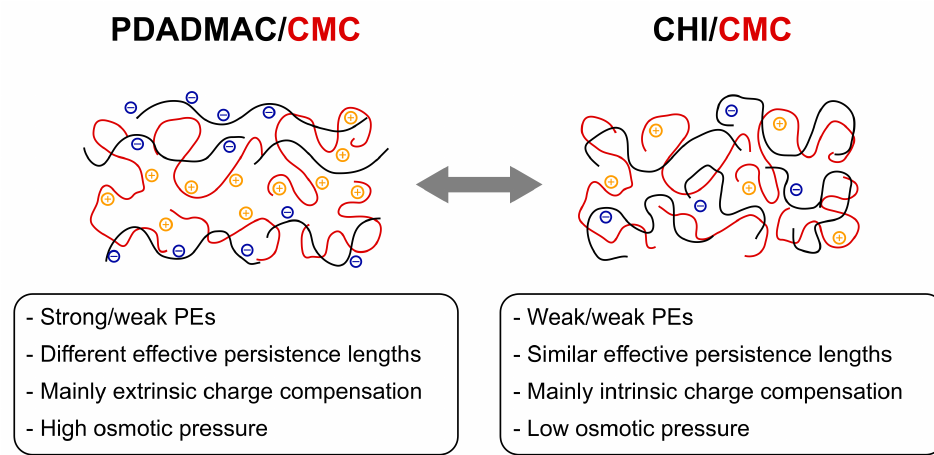
Figure 8. Proposed structures of the PEM systems PDADMAC/CMC and CHI/CMC, resulting from the high charge density of PDADMAC and the high effective persistence length. The polycations are depicted in black, the corresponding negatively charged counter ions in blue. The polyanions are depicted in red, the corresponding positively charged counter ions in